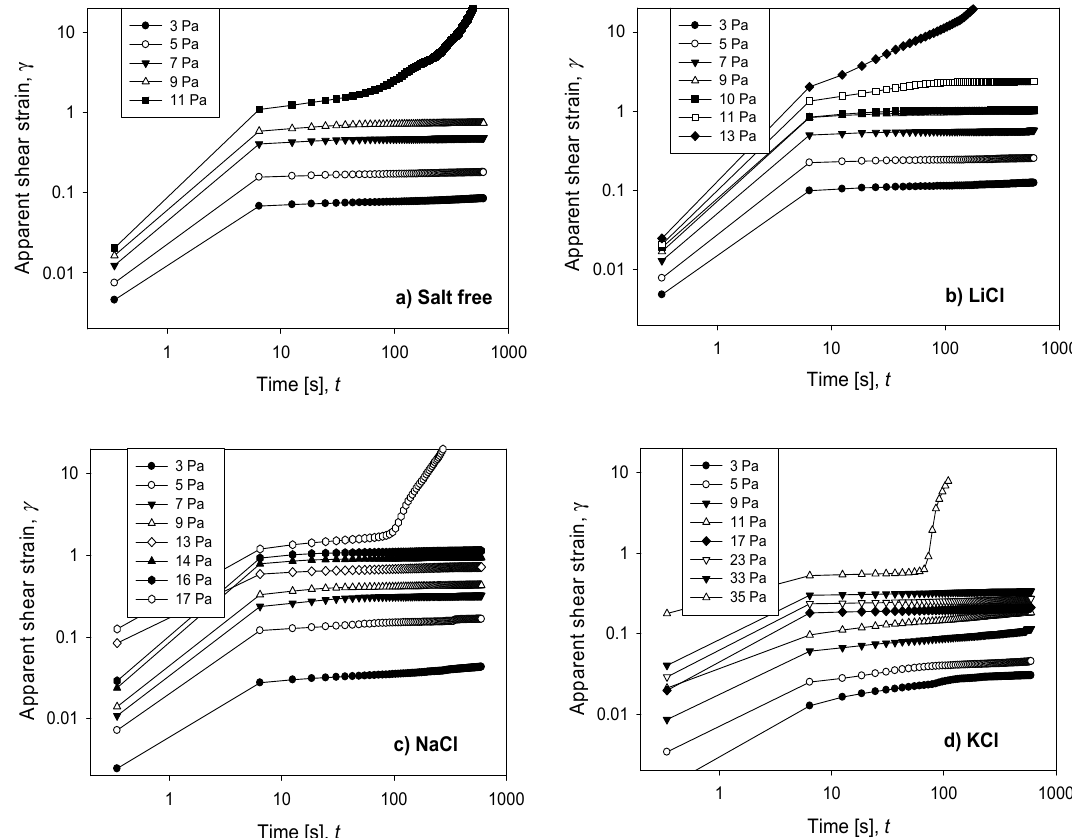
Figure 1. Apparent shear strain as a function of time for increasing values of applied stress on silica suspensions formulated at natural pH and different salts (ca. 0.5 M): ( a ) salt-free, ( b ) LiCl, ( c ) NaCl, and ( d ) KCl.